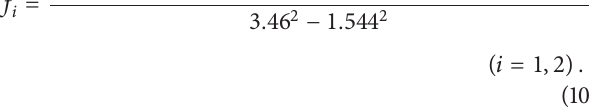
Figure 4: Blazed grating coupler discretization process. (a) Com- mon blazed grating. (b) Discrete multilevel grating. (c) Binary grating.